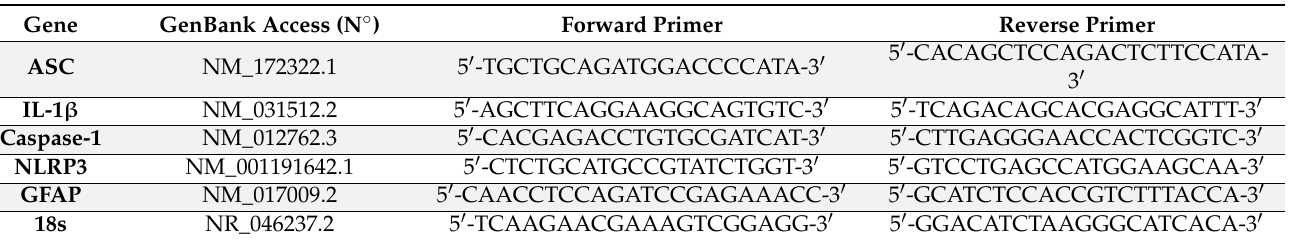
Table 1. Description of genes analyzed, indicating the GenBank accession number and the primer